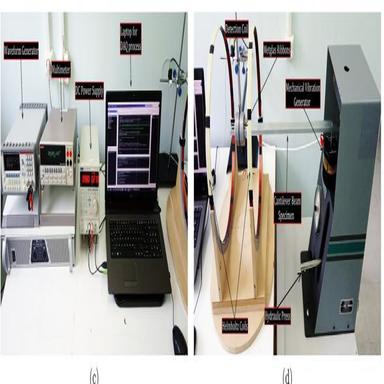
(a) Experimental setup for measuring the ribbon's frequency response, (b) a panoramic view of the non-frequency response experimental setup, (c) a detailed view of the left side of the non-frequency response experimental setup, (d) a detailed view of the right side of the non-frequency response experimental setup.